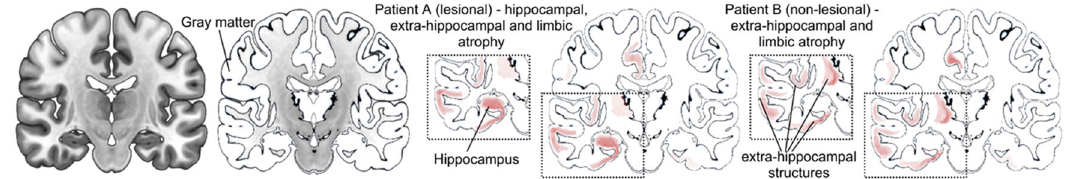
Fig. 1 Conceptual representation of brain atrophy in two hypothetical patients with TLE. Patient A is an example of a lesional case and Patient B is an example of a non-lesional case. Note that atrophy (red regions) may occur in different regions and with subtle differences in intensity, but the pattern of atrophy follows a similar extra-hippocampal and limbic anatomical